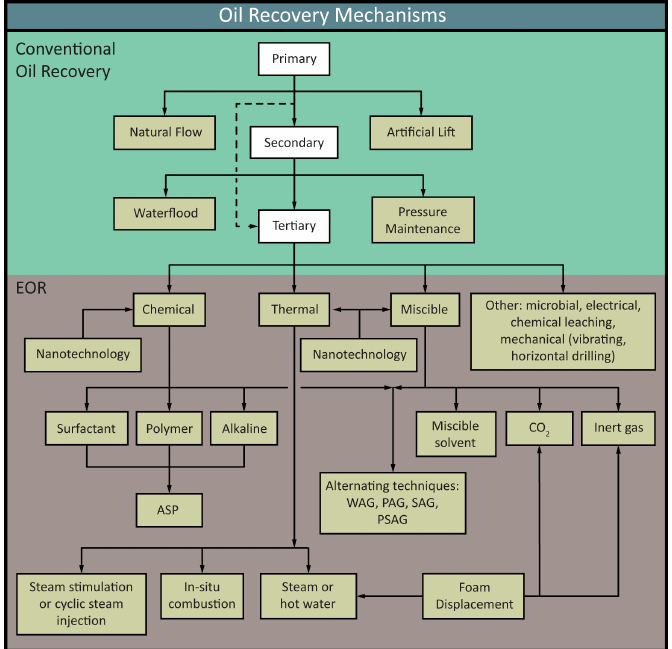
Figure 1. Scheme with the most relevant oil recovery techniques, from primary and secondary recoveries (or conventional mechanisms) to tertiary or enhanced oil recovery (EOR), and possible applications of nanotechnology in EOR. Figure adapted from Ref.